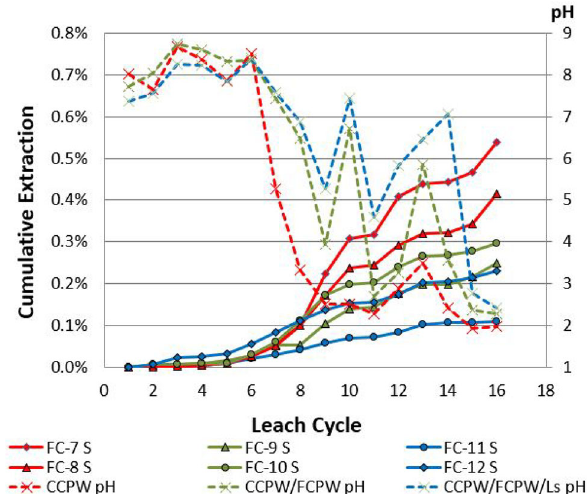
Fig. 4 Cumulative extraction of sulfur and pH (dashed lines) in different leach